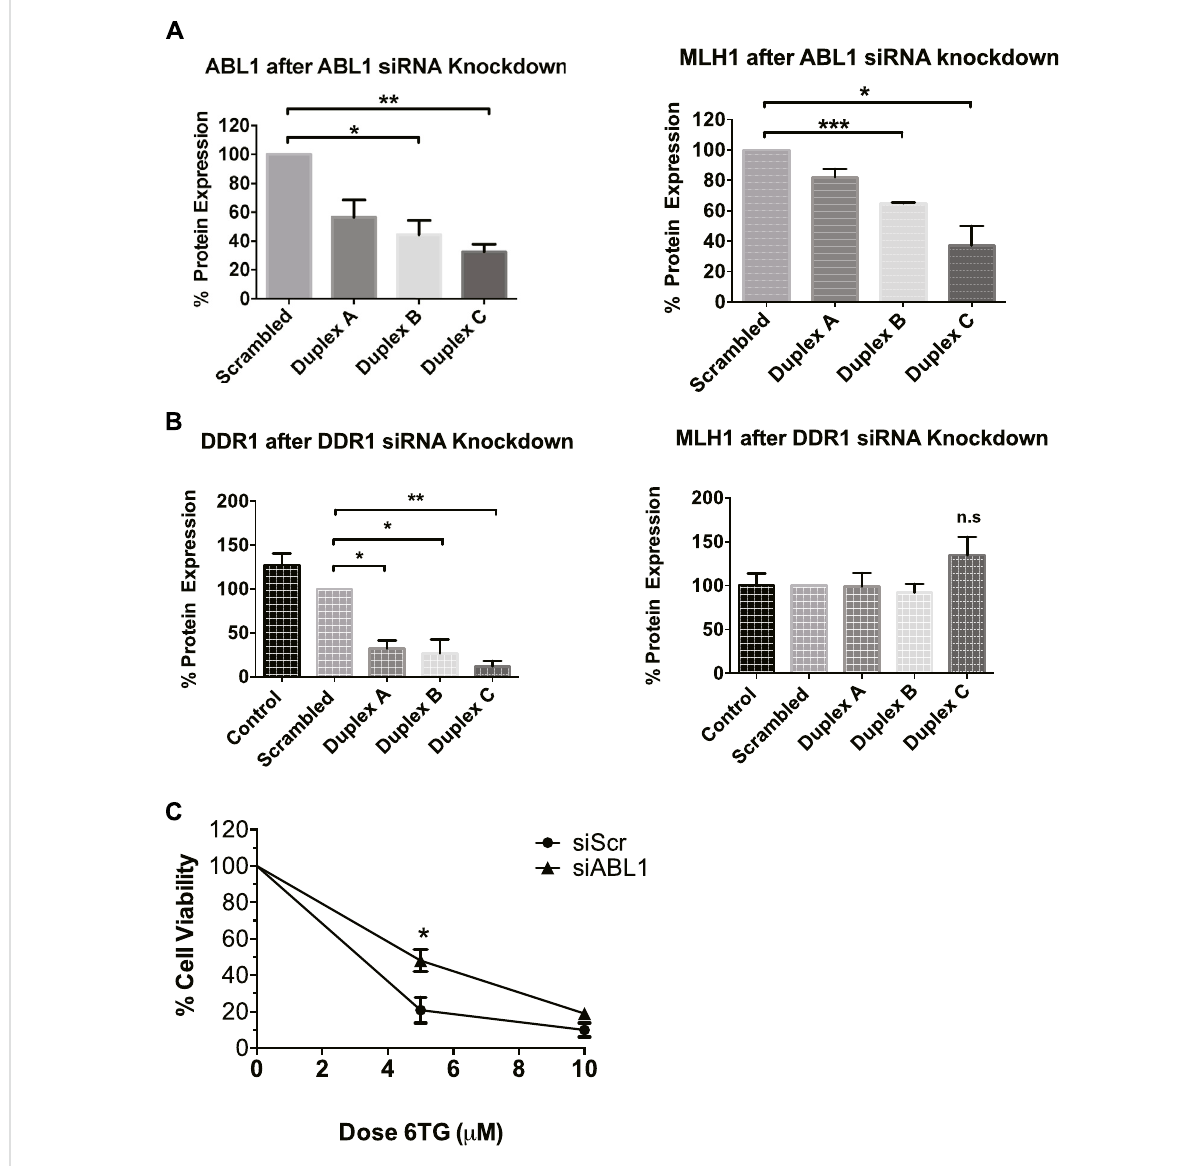
ABL1butnotDDR1knockdownreducesMLH1proteinlevelandfunction. (A) Quanti fi cationofwesternblotsforABL1(left)andMLH1(right)after transfection with siRNA duplexes against ABL1 or scrambled control in HEK293 cells. n = 3, statistical signi fi cance determined by 1-way ANOVA